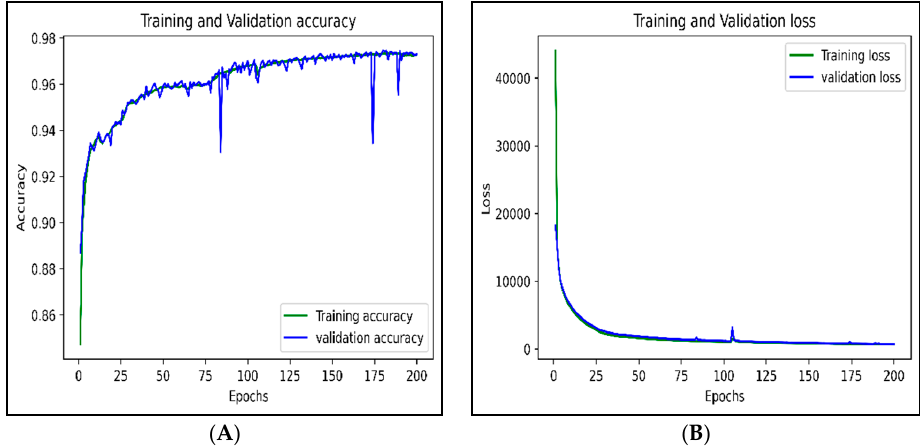
Figure 16. ( A,B ): Accuracy and Loss curves for Wednesday sub-dataset. Figure 16. ( A , B ): Accuracy and Loss curves for Wednesday